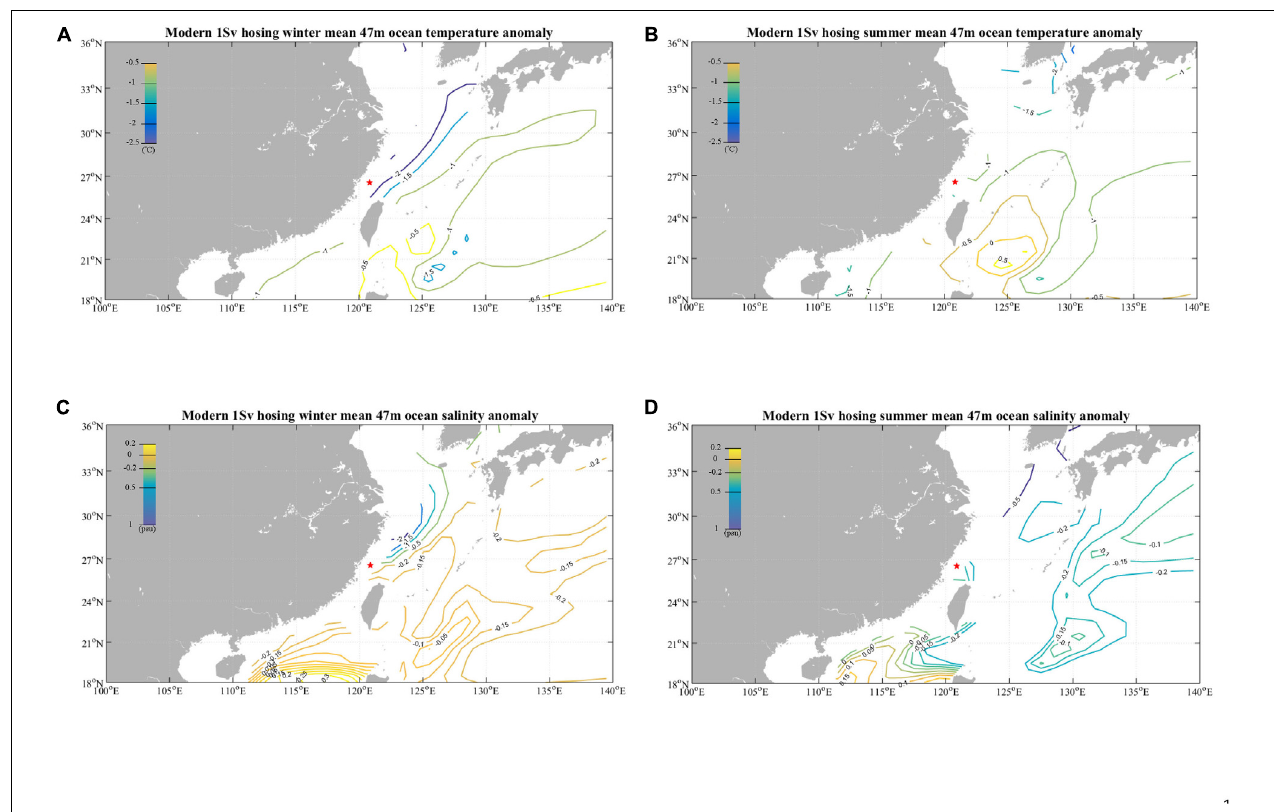
FIGURE 2 | Spatial distribution of temperature (A,B) and salinity (C,D) in winter (A,C) and summer (B,D) . Contours reveal the status at a depth of 47 m during AMOC shut-down according to the hosting